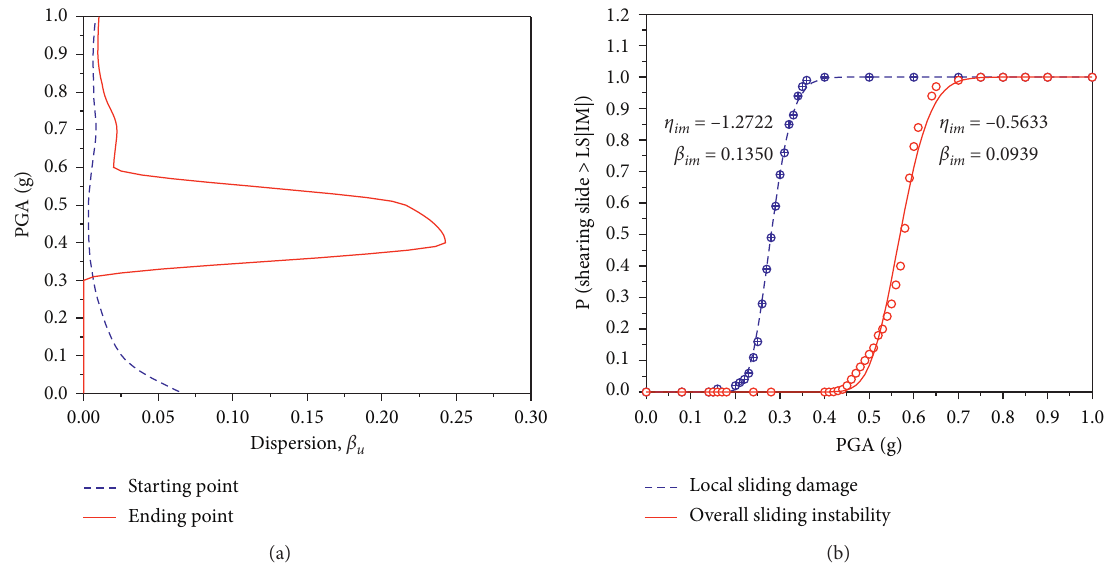
Figure 7: (a) Parameters’ dispersion of the results of LHS of the starting point on the main sliding surface and the ending point on the auxiliary sliding surface. (b) Seismic fragility curves for the concrete gravity